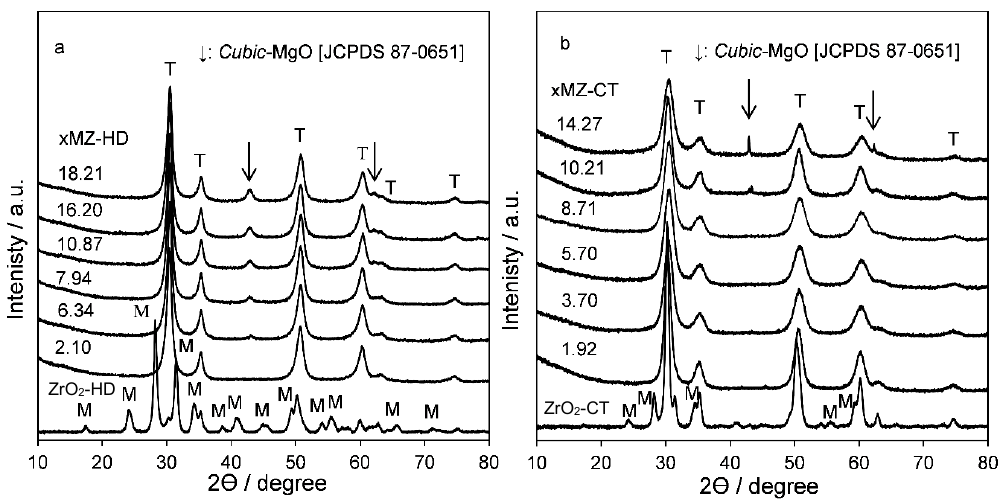
Figure 1. XRD patterns for: ( a ) xMZ–HD; and ( b ) xMZ–CT mixed oxides and corresponding pure zirconias. Table 1. Physicochemical properties of xMZ–HD and xMZ–CT mixed oxides and corresponding pure zirconias.